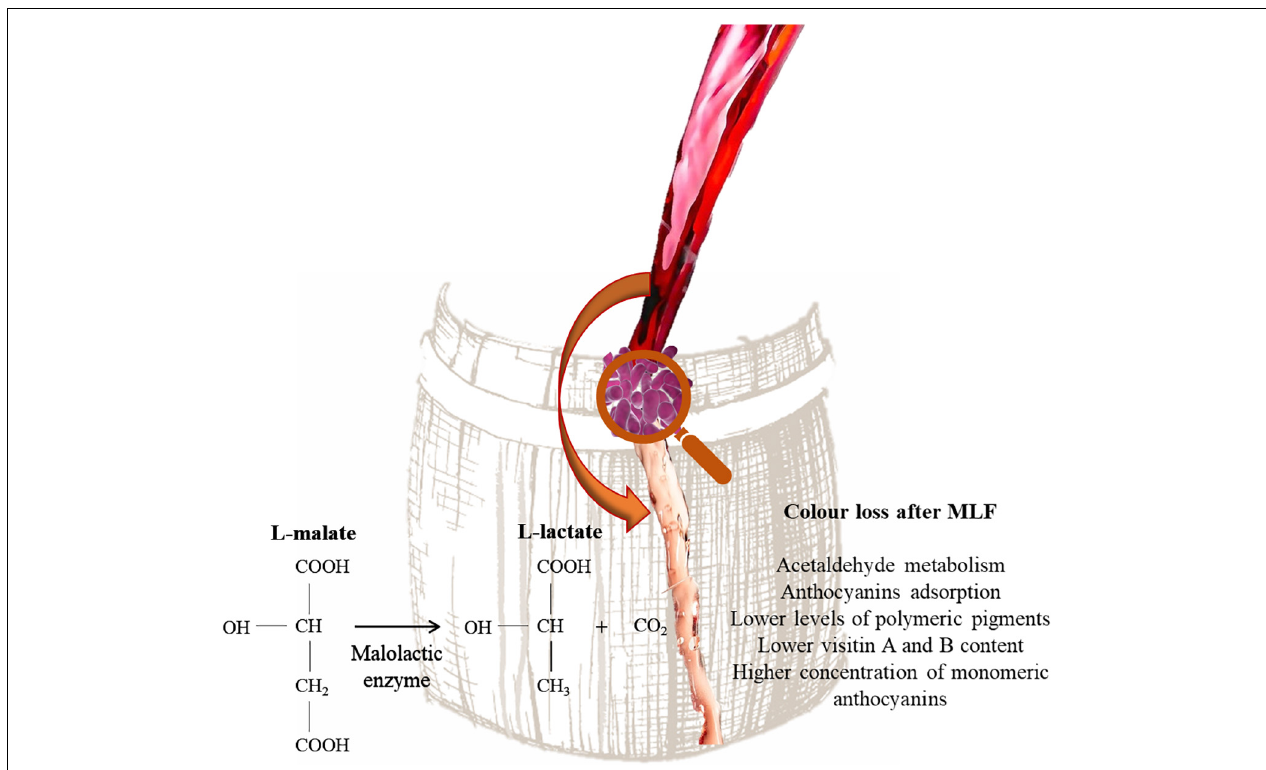
FIGURE 4 | Influence of MLF on wine